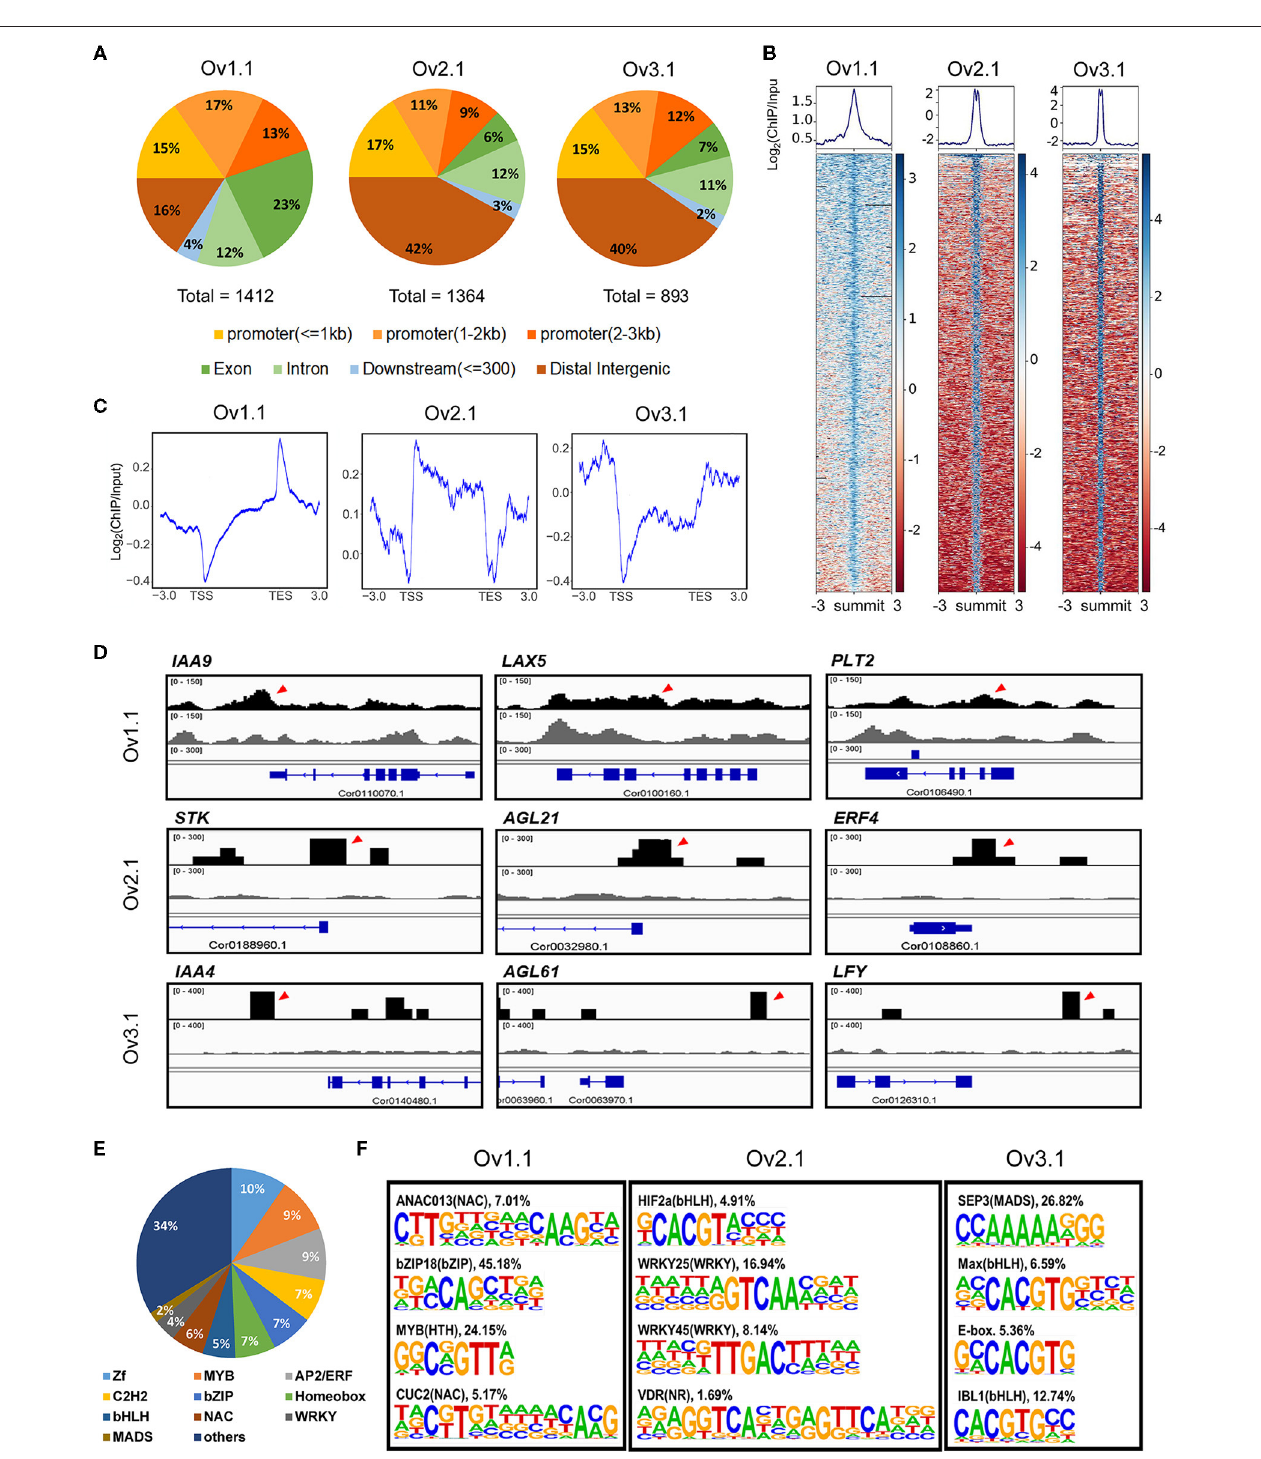
FIGURE 5 | Genome-wide analysis of ChARF3-binding sites identified by ChIP-Seq at three ovule development stages. (A) Distribution of ChARF3-binding sites in different genomic locations (exon, intron, promoter, downstream, and intergenic regions). (B) Heatmaps of ChIP-seq signal densities of ChARF3 showing enrichment near the summit of peaks. The value of Log 2 (ChIP/Input) reflects the intensity of the binding sites in ChIP samples compared with Input controls. (C) Distribution of ChARF3-binding sites near transcription start site (TSS) and transcription end site (TES) regions. (D) Integrative Genomics Viewer (IGV) visualization of representative examples of ChIP-seq binding profiles at selected targeted sites. (E) Distribution of transcription factors across all cis -regulatory motifs. (F) Significantly enriched cis -regulatory motifs among the ChARF3-binding sites at three ovule development stages. Log 2 P -value < − 4.32.